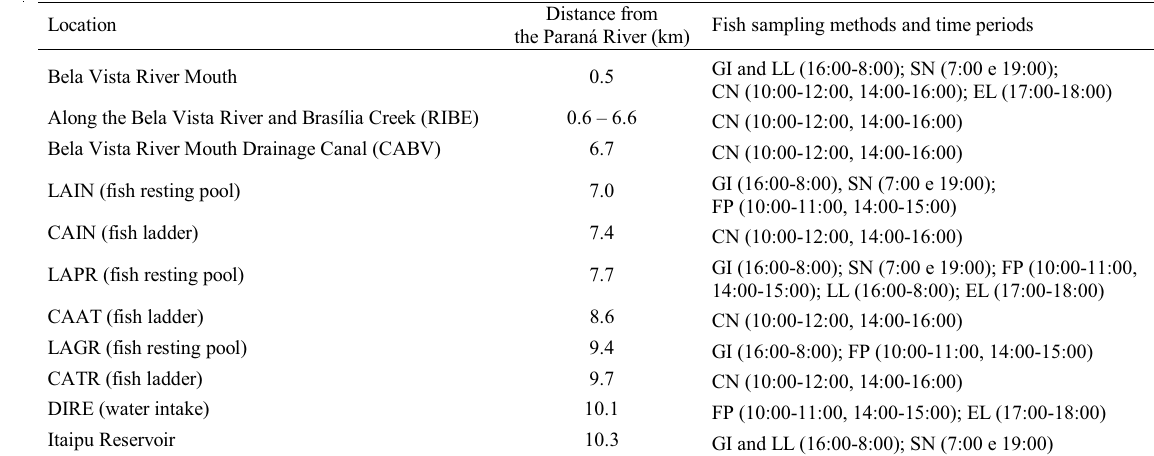
Table 1. Location of the sampling stations along the Canal da Piracema, distance from the Paraná River (km), and the fishing gear used (GI: gillnets and trammel nets; LL: longlines; SN: seining nets; CN: cast nets, FP: fishing pole; and EL: electrofishing). Numbers in parentheses are the times of day at which the different gear was